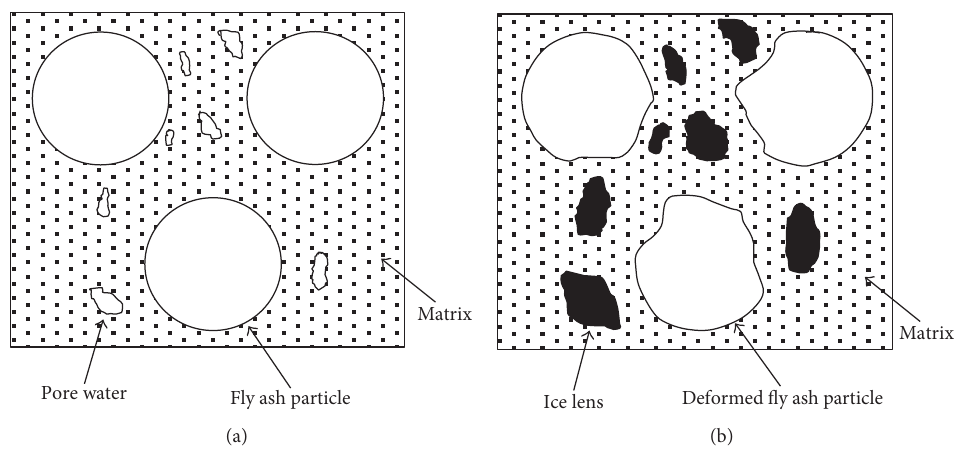
Figure 7: Schematic of foamed matrix: (a) before frost action and (b) after frost